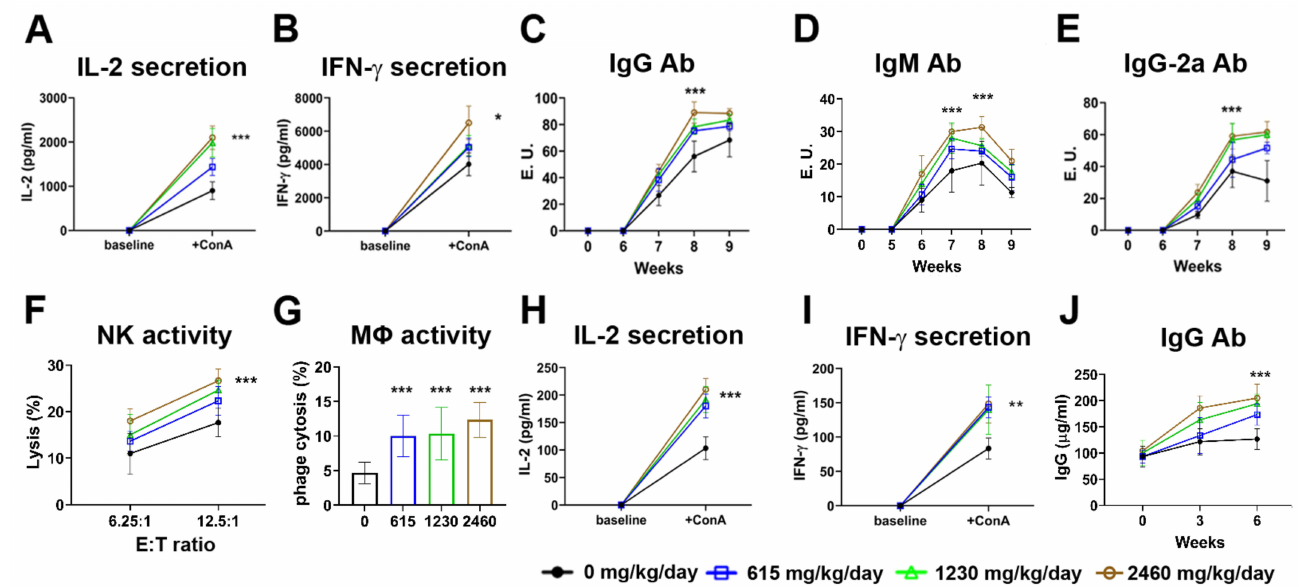
Figure 5. Arthrospira may trigger adaptive and innate immunities in vivo. ( A , B ) Arthrospira enhances IL-2 and IFN γ expression in ovalbumin (OVA)-immunized Balb/c mice. Splenocytes from OVA-immunized Balb/c mice were stimulated by adding ConA (5 µ g/mL) in medium. Cytokine levels of IL-2 (pg/mL) and IFN γ (pg/mL) were detected using the ELISA kit. Significant increases in IL-2 and IFN- γ levels were observed in the Arthrospira 2460 mg/kg/day group (* p < 0.05 and *** p < 0.001, compared to control). ( C – E ) Arthrospira enhances IgG, IgM, and IgG 2a Ab level in OVA-immunized Balb/c mice. Balb/c mice with three different doses of Arthrospira (615, 1230, or 2460 mg/kg/day) that were challenged with 50 and 100 µ g of chicken egg OVA. IgG (E.U), IgM (E.U), and IgG 2a Ab (E.U) levels were detected using the ELISA Quatitation Set. Significant increases in IgG, IgM, and IgG 2a Ab levels were observed at 8 weeks in the Arthrospira 2460 mg/kg/day group (*** p < 0.001, compared to control). ( F , G ) Arthrospira enhances natural killer (NK) cell and macrophage activities in Balb/c mice. The NK cell and macrophages activities from Balb/c mice with three different doses of Arthrospira (615, 1230, or 2460 mg/kg/day) were all higher than the control group (*** p < 0.001, compared to control). ( H , I ) Arthrospira enhances IL-2 and IFN- γ levels in Balb/c mice. For innate response, the splenocytes were isolated from Balb/c mice with three different doses of Arthrospira (615, 1230, or 2460 mg/kg/day). After 5 µ g/mL ConA stimulation, significant increases in IL-2 and IFN- γ levels were observed in the splenocytes from the Arthrospira treatment groups (** p < 0.01 and *** p < 0.001, compared to control). ( J ) Arthrospira enhances IgG Ab level in Balb/c mice. Sera samples were harvested at the beginning and 3 and 6 weeks from the Balb/c mice with three different doses of Arthrospira (615, 1230, or 2460 mg/kg/day). A significant increase in IgG was observed in Arthrospira treatment groups using the ELISA Quatitation Set (*** p < 0.001, compared to